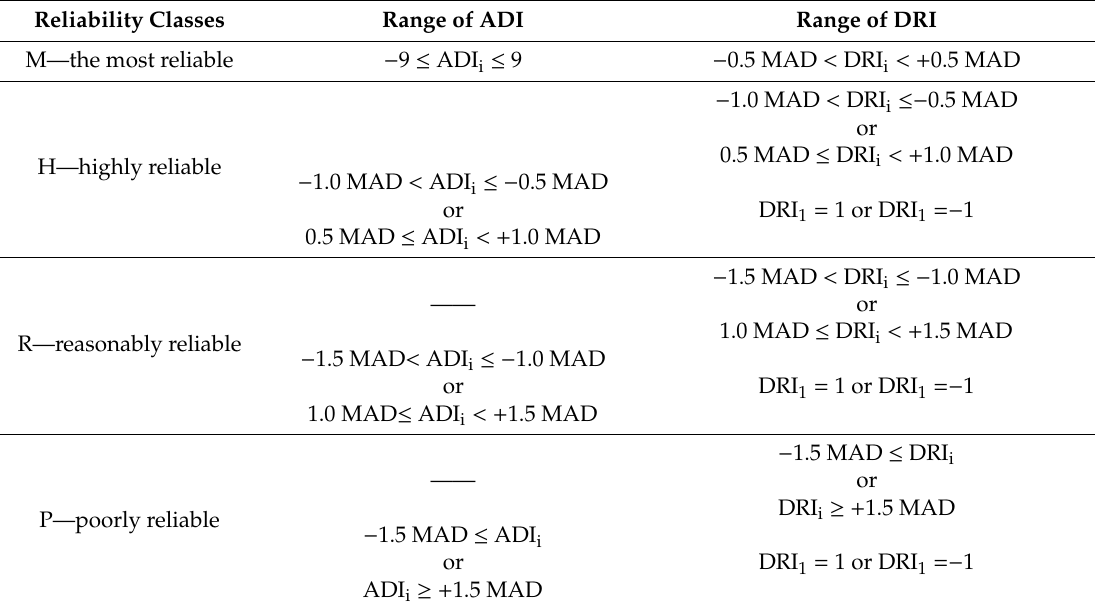
Table 2. LandScan reliability